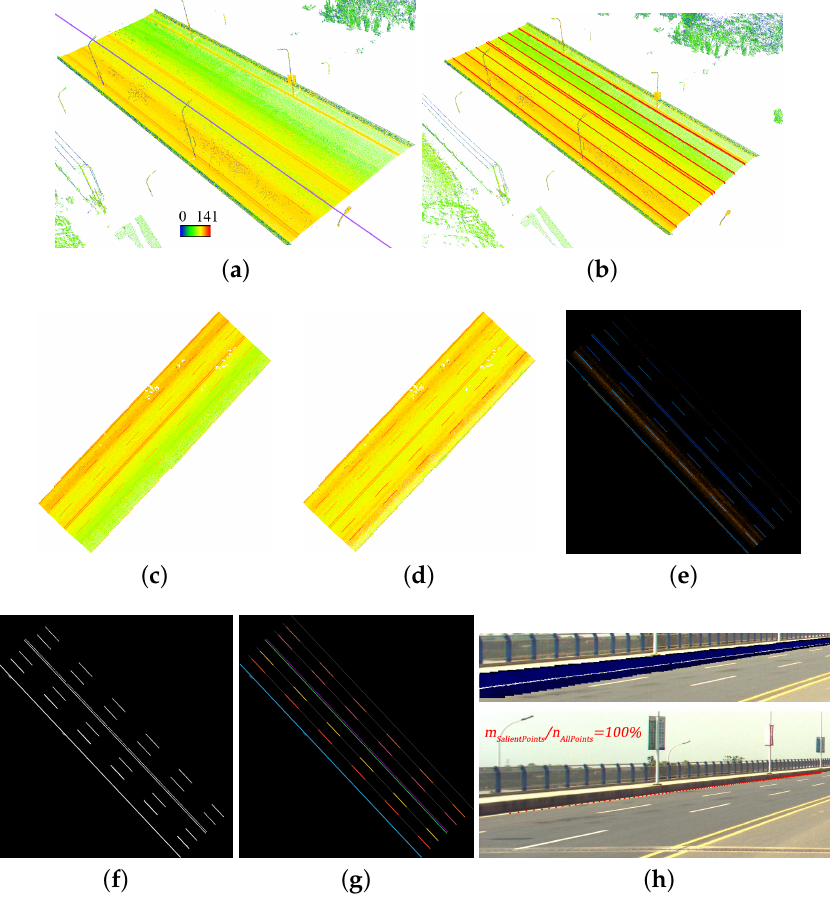
Figure 20. A two-way six-lane road section. ( a ) The raw data. The purple line is the trajectory. ( b ) The red 3D lane lines are presented in the colored point cloud. ( c ) The road points. ( d ) The road points after intensity correction. ( e ) The intensity image. The blue part is the lane markings and the orange part is the interference. ( f ) The binary image. ( g ) The colors indicate the groups of the clustered lane-marking pixels. The white lines are the lane lines fitted from the pixels of each group. ( h ) The textural saliency analysis. The upper picture shows the saliency values of the buffers around each sampling point. In the lower picture, the red points are the salient sampling